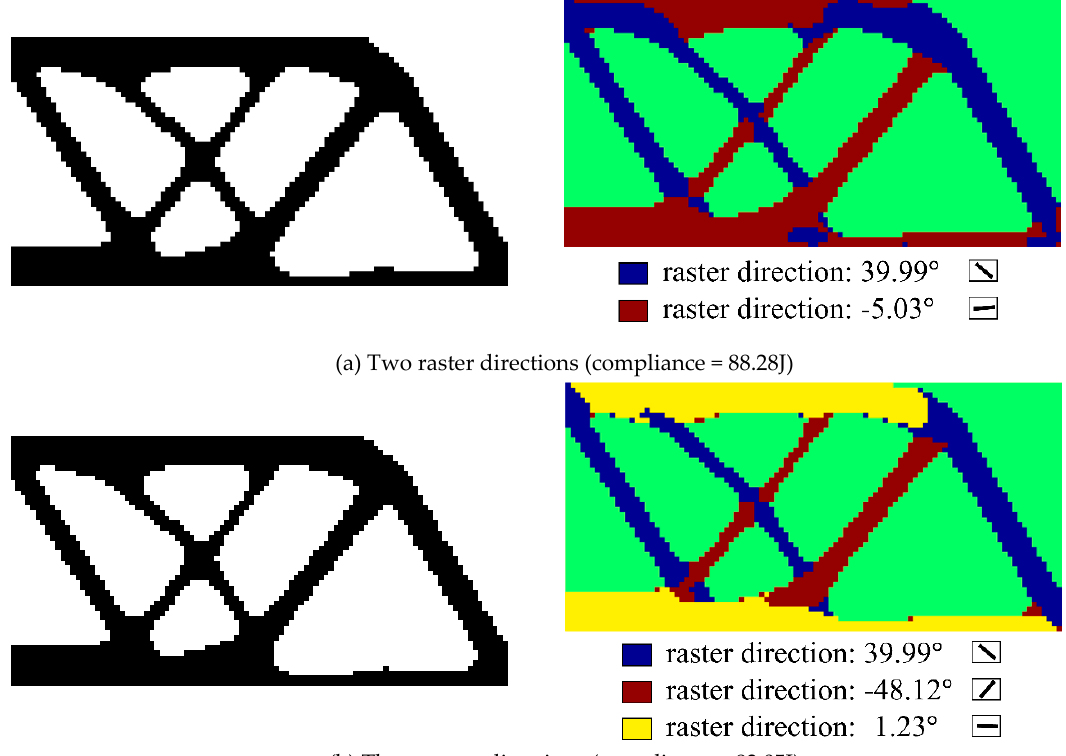
= 𝟏 , the red 𝟏 = 𝟏 , and the green 𝟑